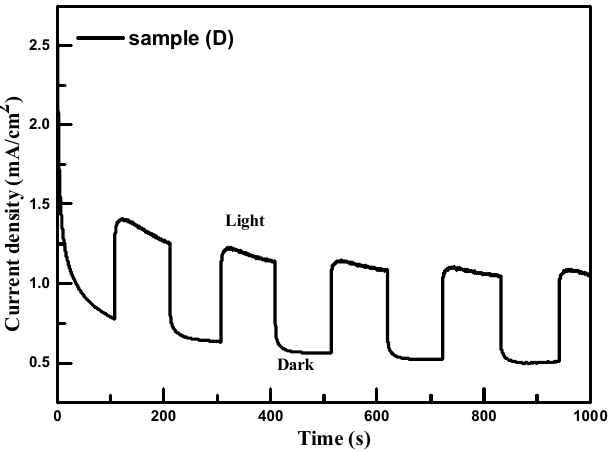
Figure 8. Current density of sample C as a function of time at applied voltage of 0 V vs. Ag/AgCl in the 0.35 M Na 2 S + 0.25 M K 2 SO 3